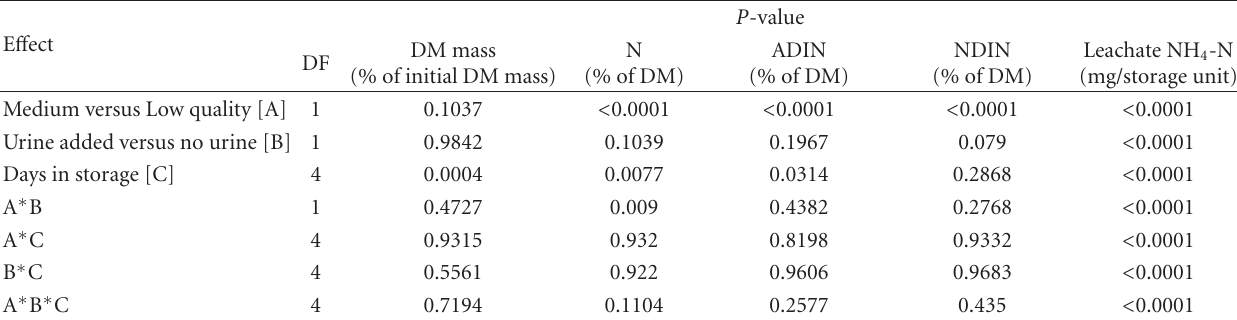
Table 4: ANOVA results for N content (DM basis) of manure in storage in the rainy season experiment, as a percent of the initial manure N content, and for NH 4 -N content (mg NH 4 -N per manure storage unit) of leachate collected from manure in storage in the rainy season experiment. Fixed e ff ects are the manure quality (Medium versus Low quality), the presence or absence of urine in the manure, and the number of days the manure was incubated (0, 6, 12, 18, 24, or 30 days). Terms for the interaction between fixed e ff ects are denoted by fixed e ff ects terms separated by an asterisk ( ∗ ). DF represents the degrees of freedom of the test.